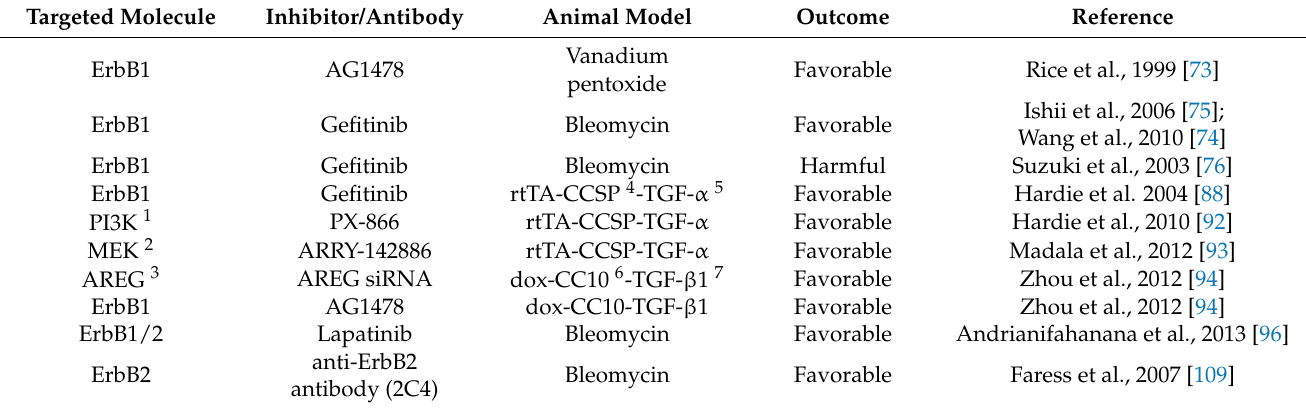
Table 1. Anti-ErbB/ligand approaches in preclinical models of lung